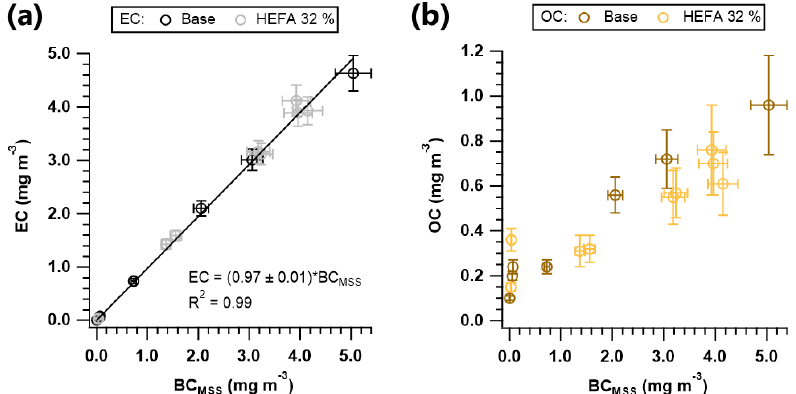
Figure 3. (a) Scatter plot and linear regression line of the mass concentrations of elemental carbon (EC) and black carbon measured with the micro soot sensor (BC MSS ). (b) Scatter plot of the mass concentrations of organic carbon (OC) and BC MSS . Note that dark colours represent measurements with base fuel (Jet A-1), and light colours represent measurements with the HEFA blend